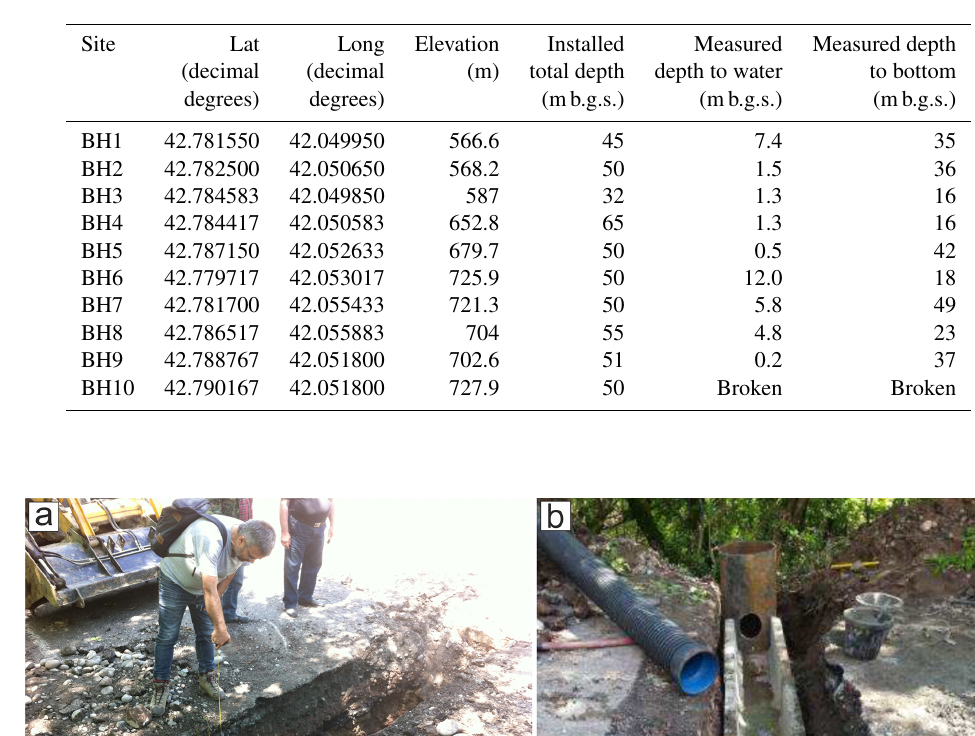
Table 1. Characteristics of measured piezometers and water table depth; b.g.s. refers to depths below ground surface.